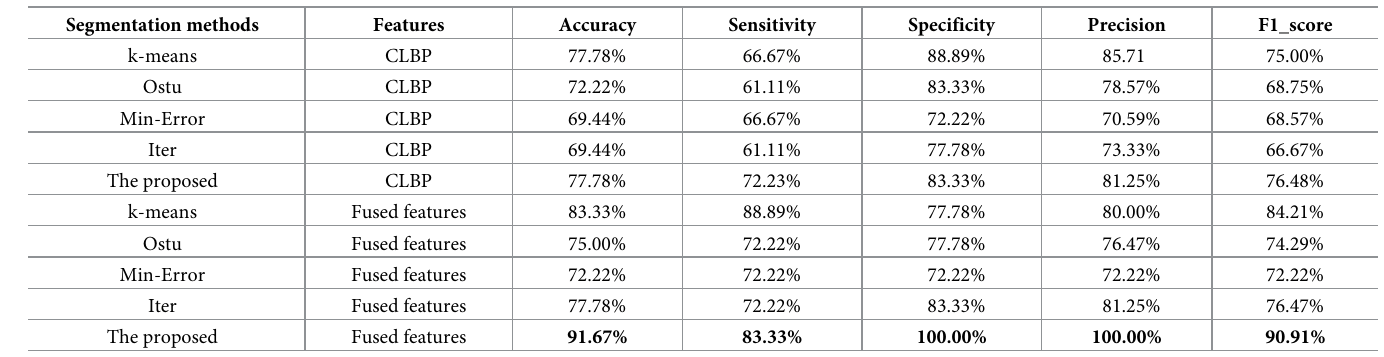
Table 9. Comparison of different segmentation methods at